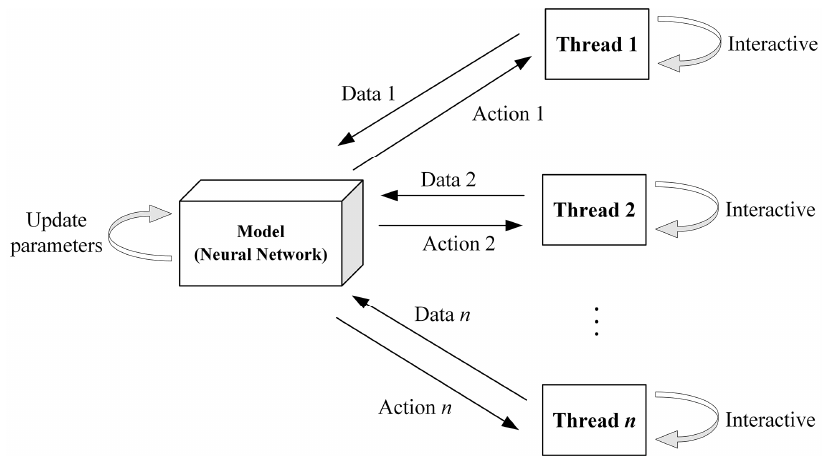
Figure 6. Multithreaded training mechanism.